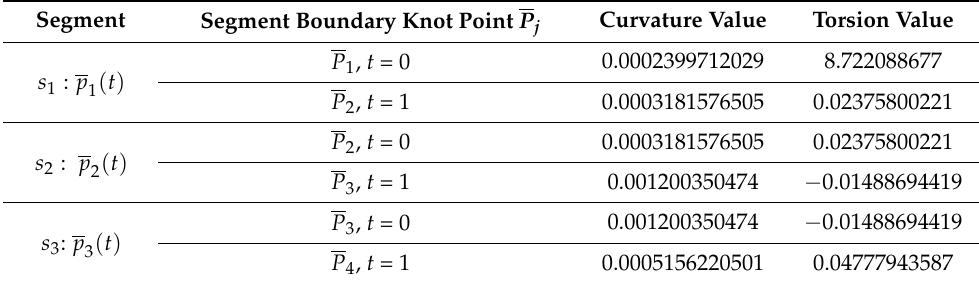
Table 6. Curvature and torsion values at boundary points of the segments.